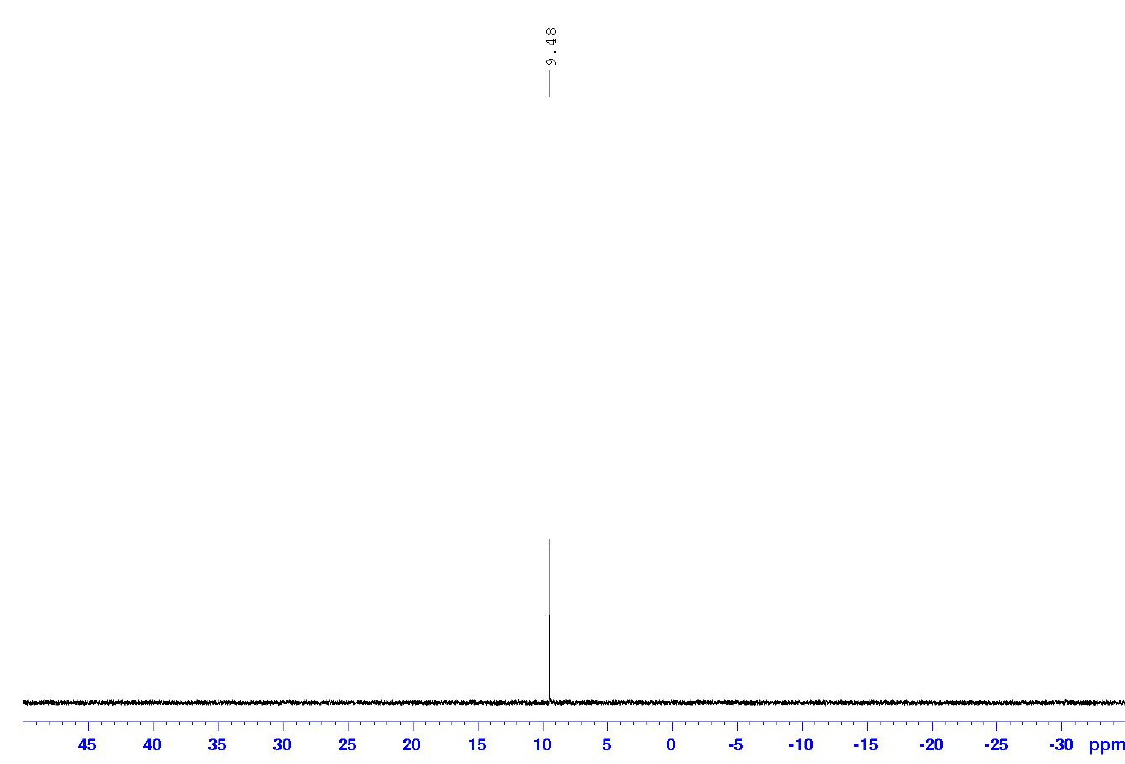
31 P NMR (500 MHz, DMSO-d